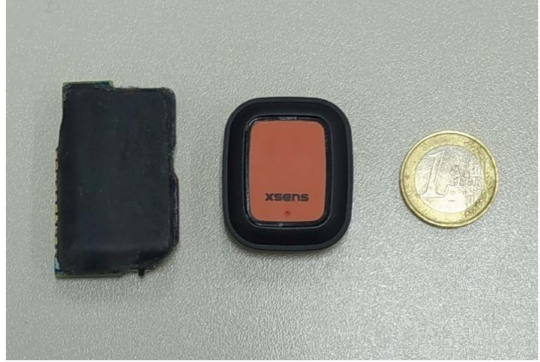
Figure 1. Relative size of the CW device and the XDOT